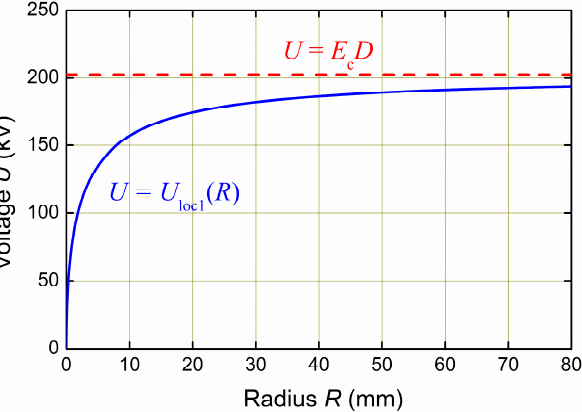
Figure 4. The blue solid line shows the dependence of the runaway threshold voltage U loc1 on the curvature radius R corresponding to the simplest local criterion (8). The red dashed straight line is the asymptotics U = E c D c